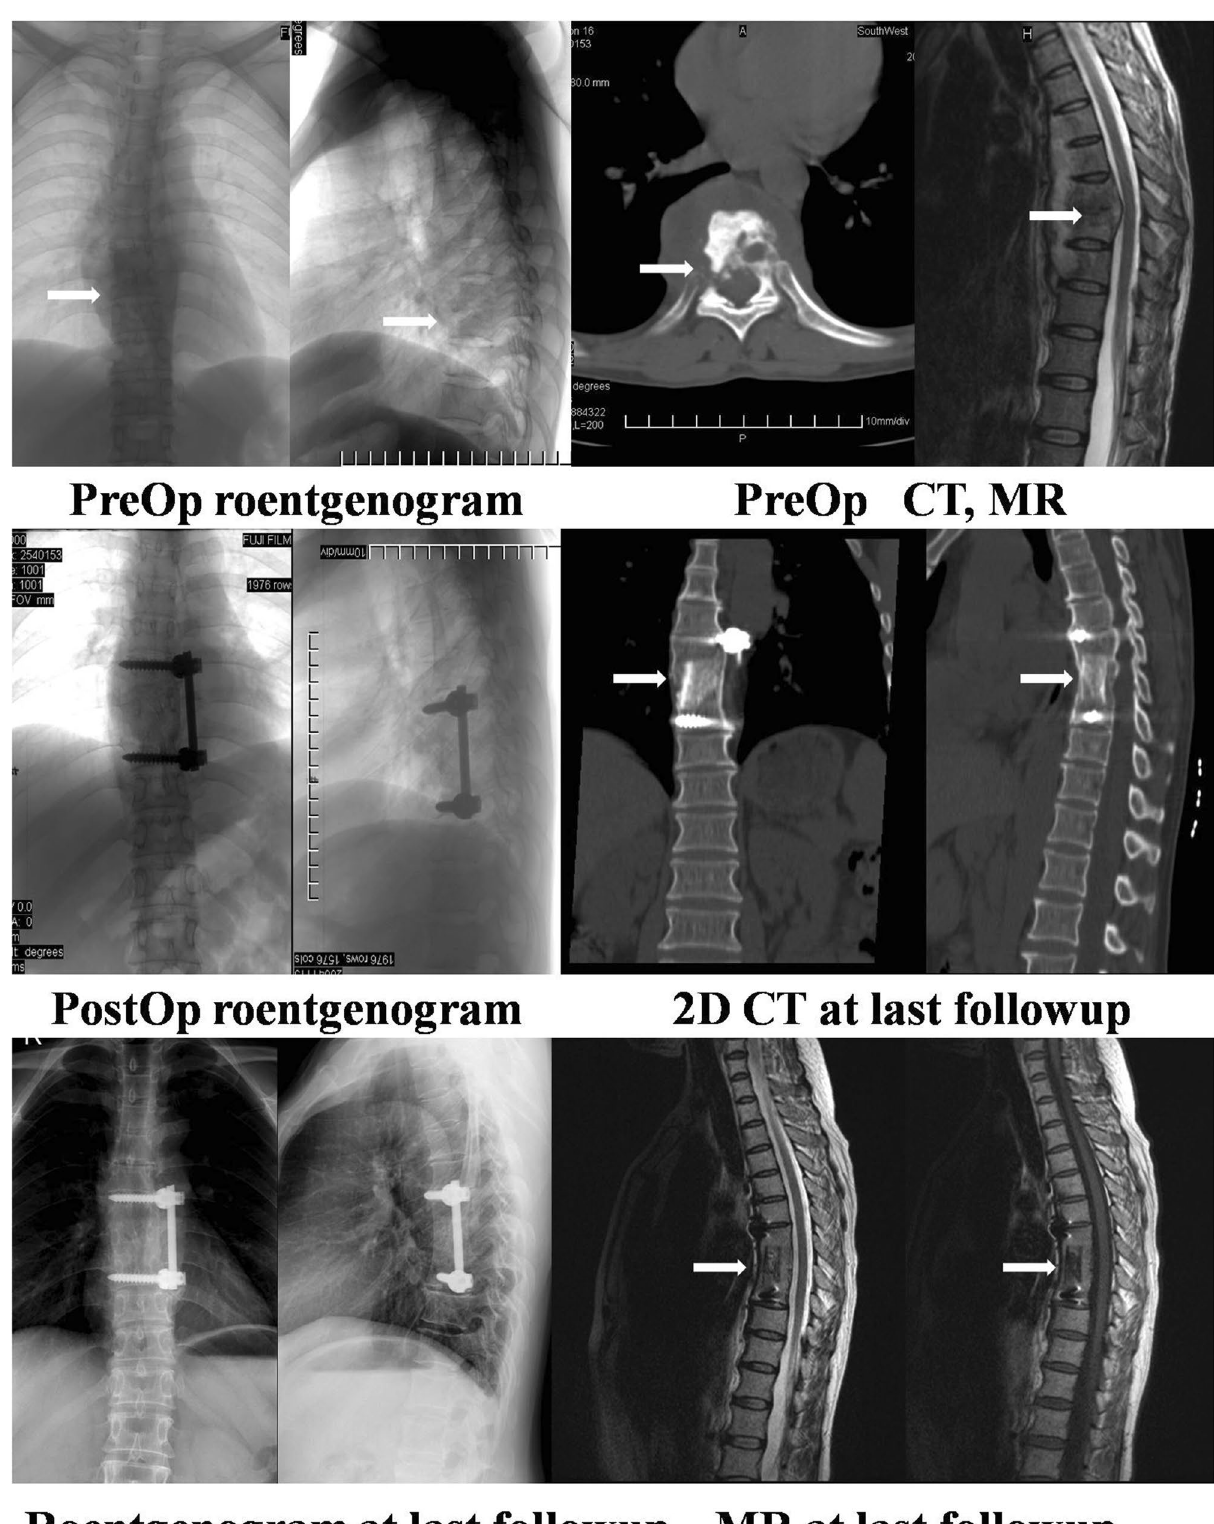
Figure 2. A 35-year-old woman complained of severe back pain and lower extremity weakness. Preoperative radiographs, CT scans and MRI scans showed T8/9 disc space with the destruction of adjacent vertebral bodies and paravertebral abscess with spinal cord compression (white arrows). The kyphotic angle was 15°. The anteroposterior and lateral roentgenograms taken after surgery showed the long segment tricortical iliac crest allograft inserted from T7–T9. The CDH rod was placed for added stability to prevent graft displacement. The kyphotic angle improved to 9°. The 2D CT scan taken at the 10-year follow-up showed that the graft integrated with the adjacent vertebral bodies. The roentgenogram showed solid bony fusion, and the loss of correction was 3°. The MR scan taken at the final follow-up showed healed vertebrae and no compression of the spinal